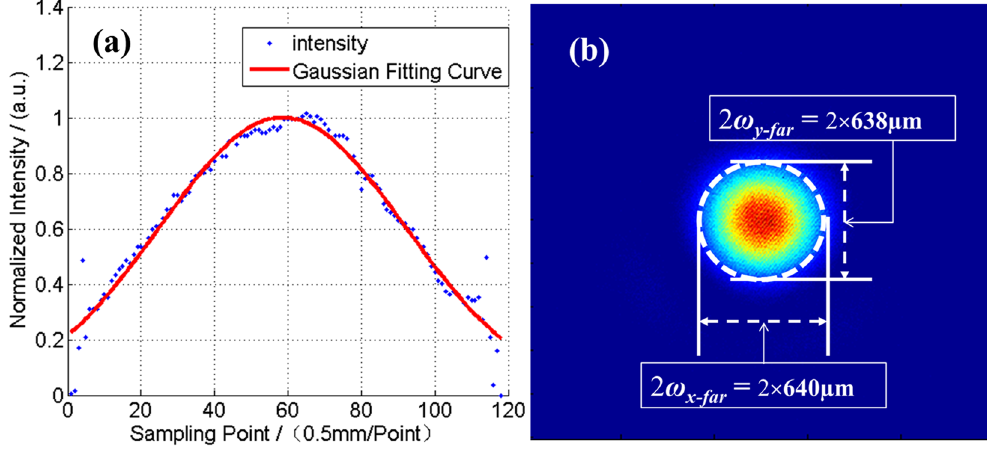
Figure 4. The intensity distributions of the near-field ( a ) and far-field ( b ) of the collimated beam with 20/400 output fiber.